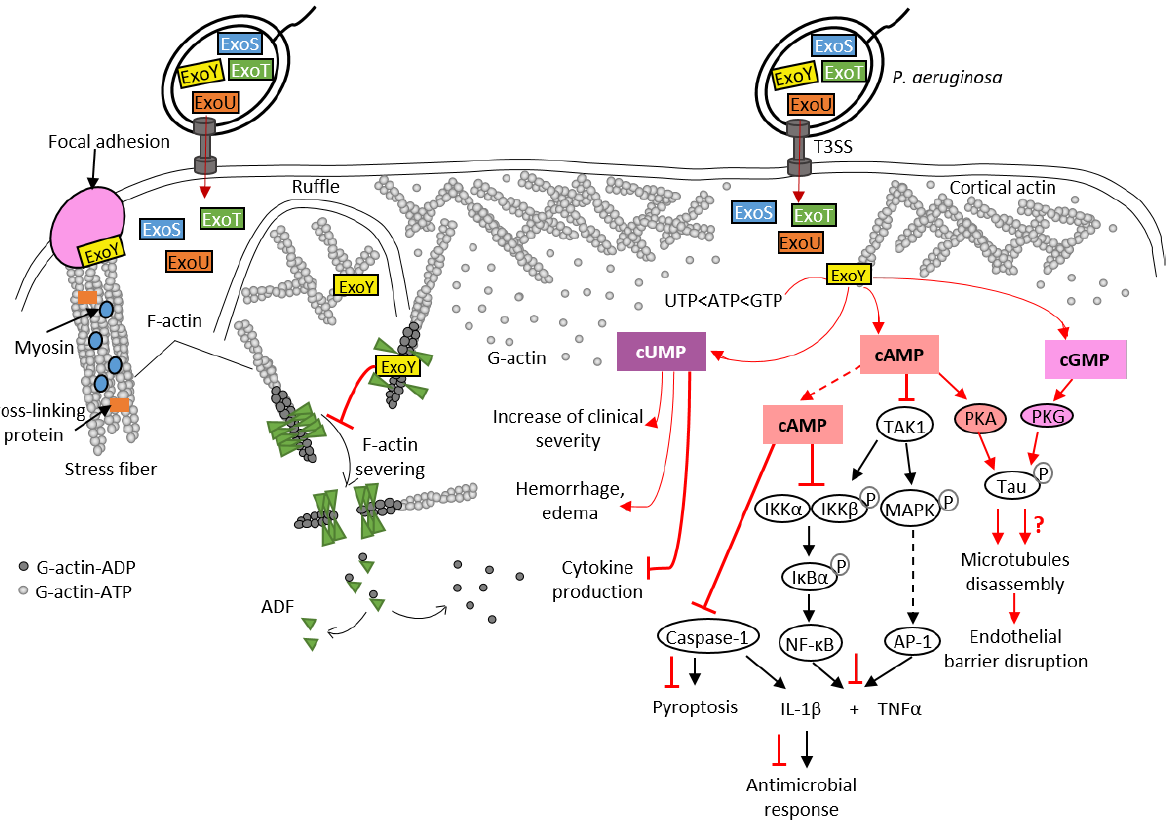
Figure 6. Pathogenicity of Pa -ExoY during Pseudomonas aeruginosa infection. Pa -ExoY (in yellow) is co-injected into host cells by the T3SS of P. aeruginosa along with three other exotoxins, ExoU, ExoT and ExoS, through the T3SS of P. aeruginosa . F-actin-activated Pa- ExoY can be recruited to the plasma membrane, to ruffles and to actin cables including stress fibers at vinculin focal adhesions [17]. Pa- ExoY alters F-actin turnover by inhibiting the cooperative binding and activity of ADF (Actin-De- polymerizing Factor). The Pa -ExoY-mediated increase in cUMP in mouse lungs coincided tempo- rally with observed clinical alterations observed such as hemorrhage, edema and inhibition of cyto- kine production [92]. Pa -ExoY is likely to contribute to suppression of pro-inflammatory response in different cell types (epithelial cells, immune cells). Pa -ExoY AC activity inhibits production of pro- inflammatory cytokines (TNFα and IL - 1β) by downregulating both NF - κB and AP -1 [103,104,106,107]. The cAMP-PKA signaling induces phosphorylation of the microtubule-associated protein Tau resulting in microtubule disassembly and endothelial barrier disruption [108 – 111]. The role of cGMP in endothelial permeability and barrier disruption remains unclear (red question mark). Physiological signaling cascades and toxin effects are shown in the same way as in Figure 3. Studies investigating the effect of deletion of the exoY gene in P. aeruginosa strains in different infection models have so far failed to reach a consensus [7,92], in part because expression of ExoY from plasmid with multiple copies compared to a single chromosomal copy can affect the outcome [92]. In epithelial cells, Pa- ExoY was previously found to po- tentially contribute to virulence by mediating bleb-niche formation via its AC activity, similarly to the ADP-ribosylation activity of ExoS, another T3SS-secreted toxin co-injected with ExoY [112]. Pa- ExoY-mediated bleb-niche formation may be due to several mecha- nisms: disruption of actin cytoskeleton leading to cell rounding [113] or microtubule breakdown as described below [108,109]. Further investigations are required to under- stand whether bleb-niche formation promotes bacterial trafficking and replication in cells. In endothelial cells, Pa- ExoY induces a PKA-dependent phosphorylation of microtu- bule-associated protein Tau by generating a cytosolic cAMP pool, and leads to the for- mation of endothelial gaps [108 – 111] (Figure 6). The effects of Pa -ExoY-AC activity on the